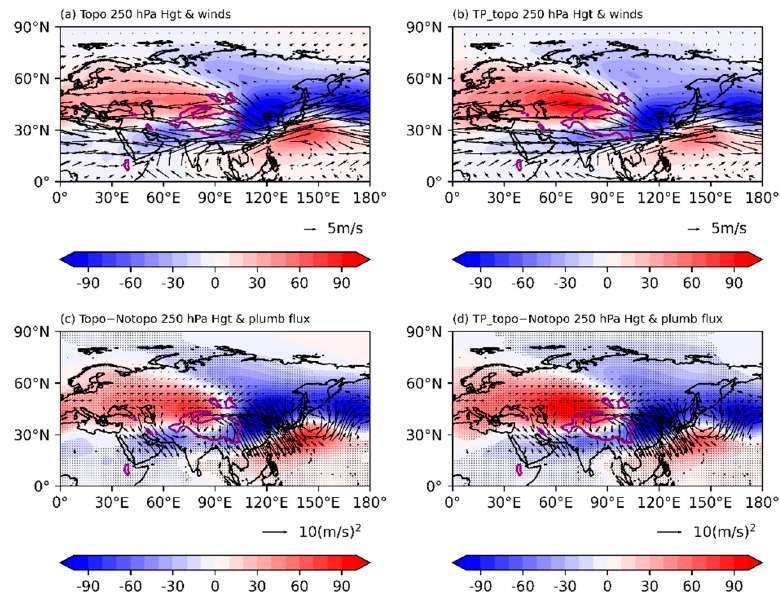
Figure 4. The climatological mean 250 hPa zonal deviation of geopotential height (shaded unit: gpm) and winds (vector, unit: m/s) in the ( a ) Topo and ( b ) TP_topo tests, and the differences in zonal deviation of 250 hPa geopotential height (shaded unit: gpm) and its associated wave flux (vector: (m/s) 2 ) between the Topo and Notopo tests ( c ), and between the TP_topo and Notopo tests ( d ). Dots denote values and black vectors ( c , d ) exceeding the 95% confidence level of Student’s t test The purple line is the 2000 m elevation contour.